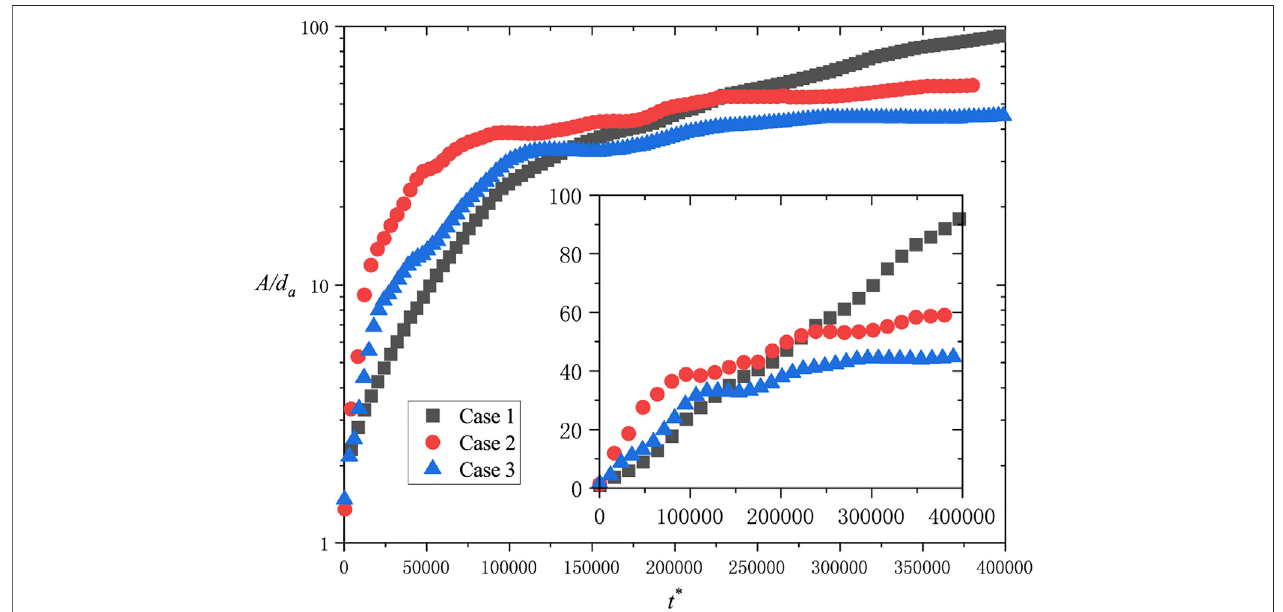
FIGURE 11 | Size distribution of surface particles on ripple topography.